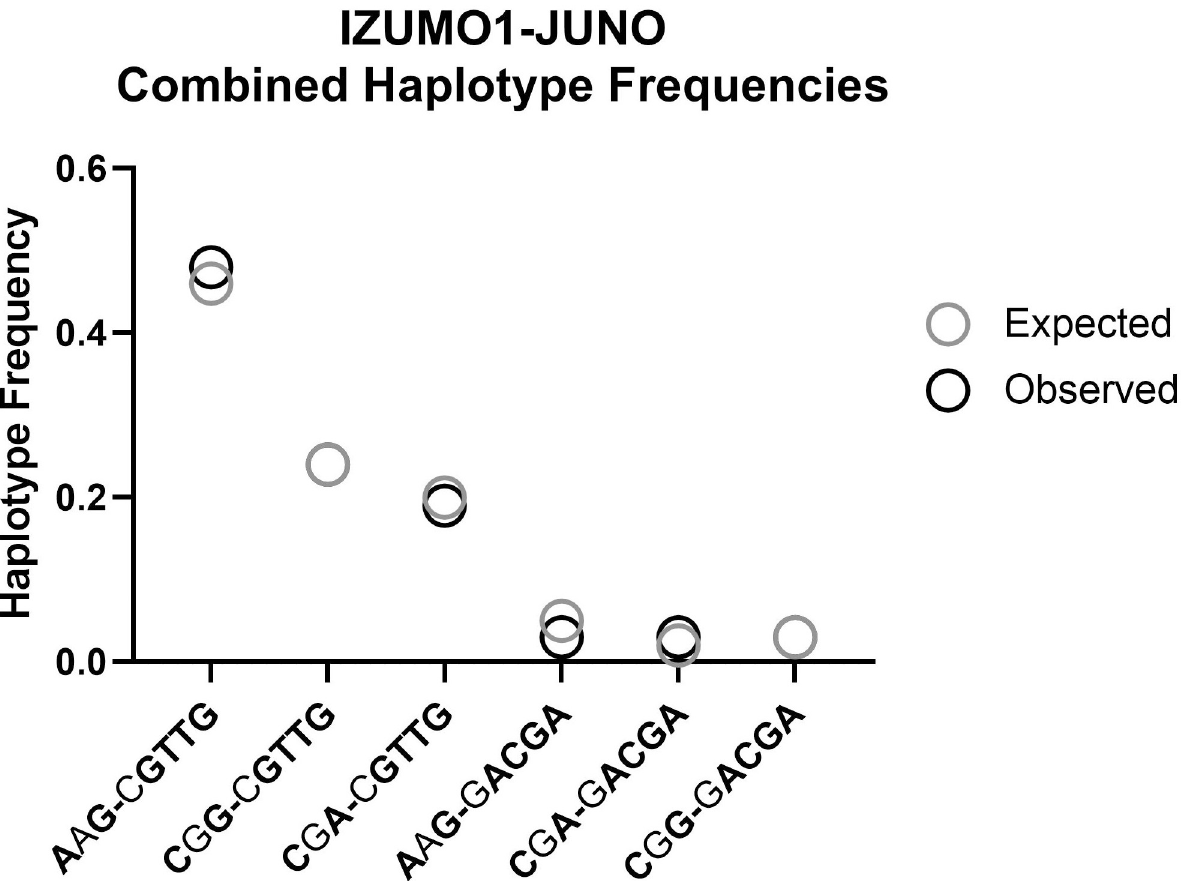
Fig 4. Expected (grey circle) versus observed (black circle) frequencies for combined IZUMO1 and JUNO